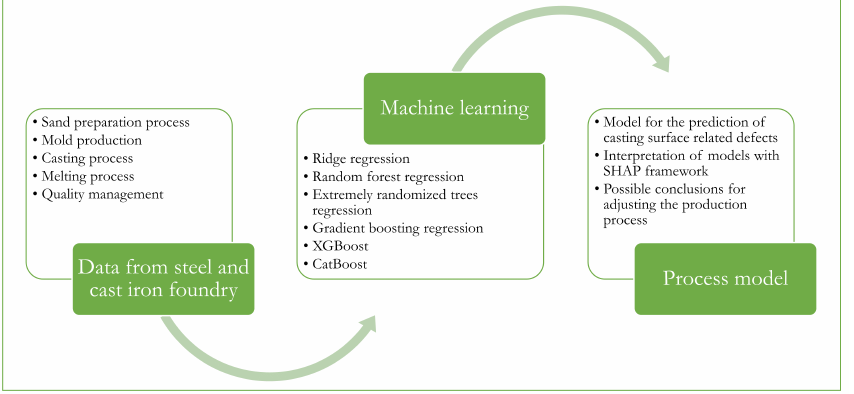
Figure 3. Concept of the machine learning